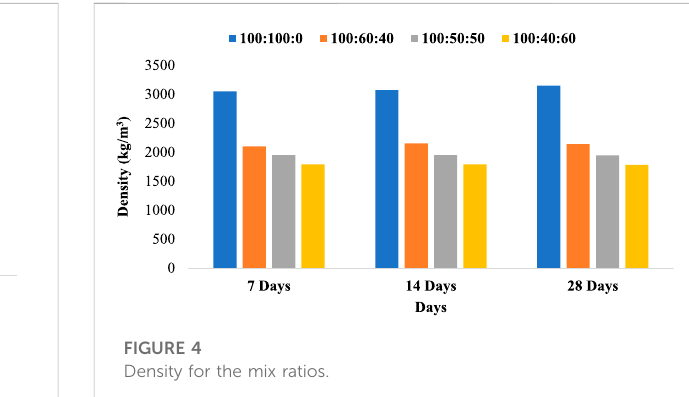
FIGURE 4 Density for the mix ratios.